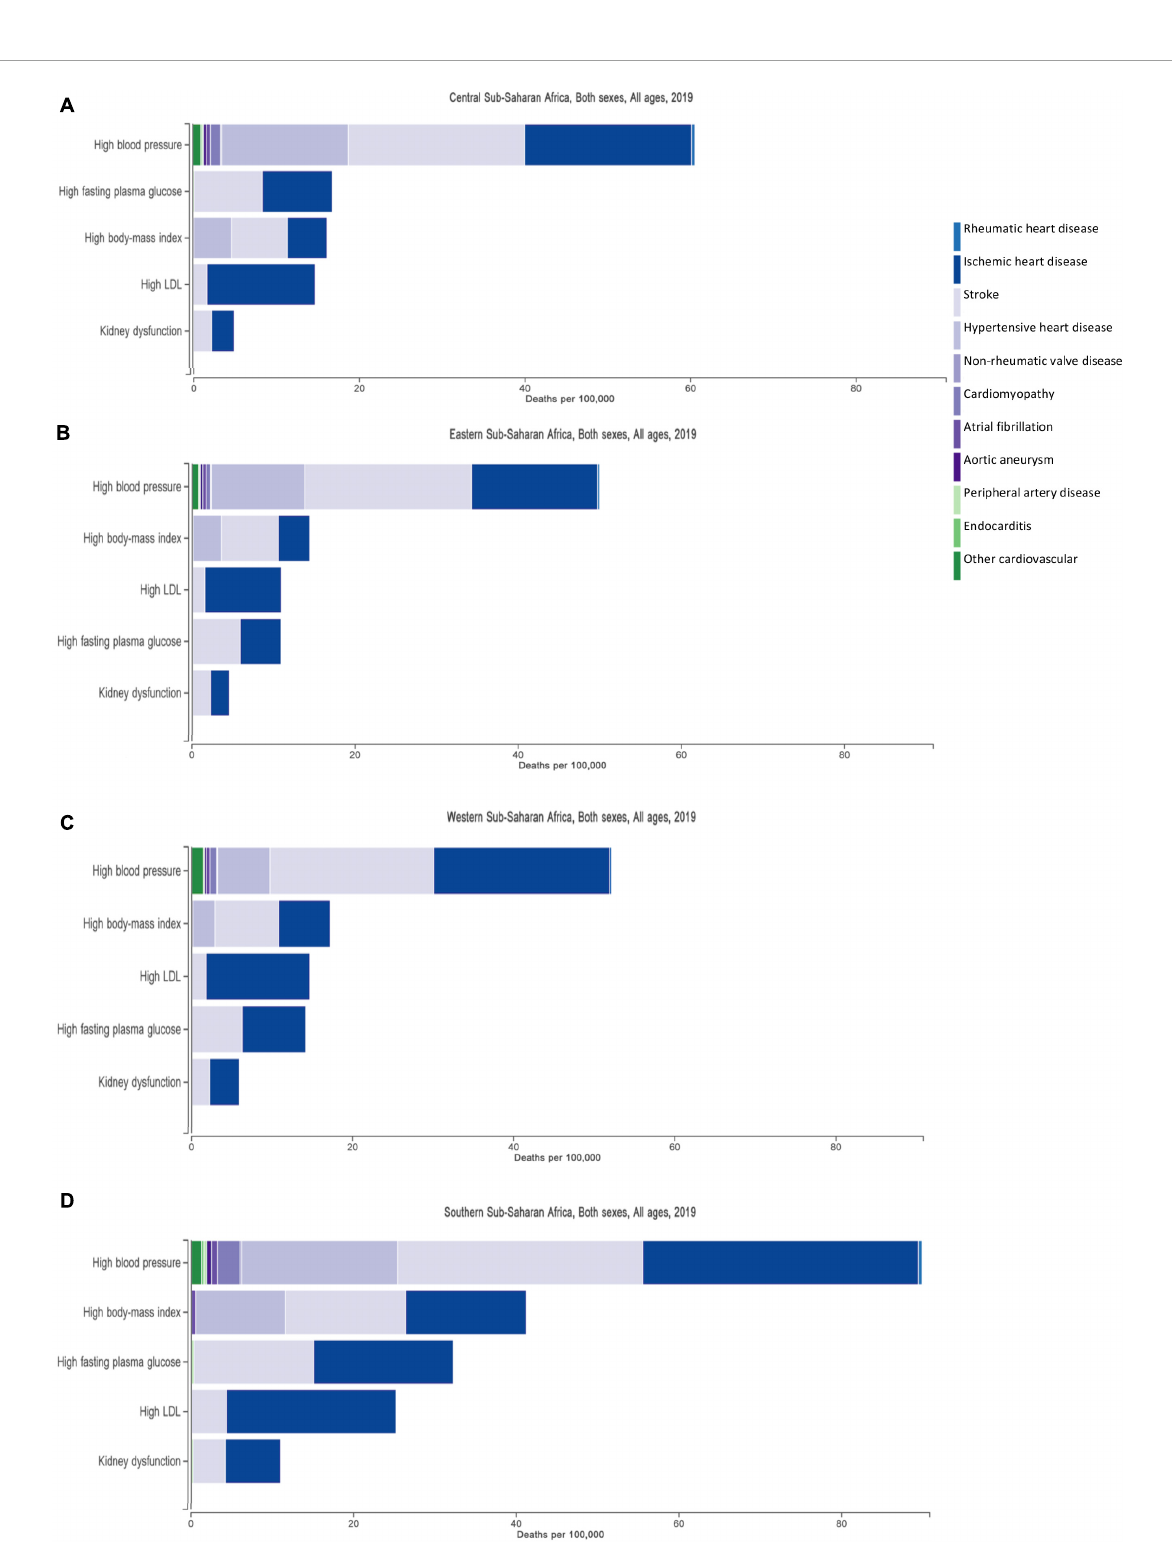
FIGURE2 Metabolic risk factors and their contribution to the burden of cardiovascular disease in four regions in Africa, —Central (A) , Eastern (B) , Western (C) , and Southern (D) Sub-Saharan Africa. The three largest contribution of risk factors are illustrated by the three prominent bars making up ischemic heart disease, stroke and hypertensive heart